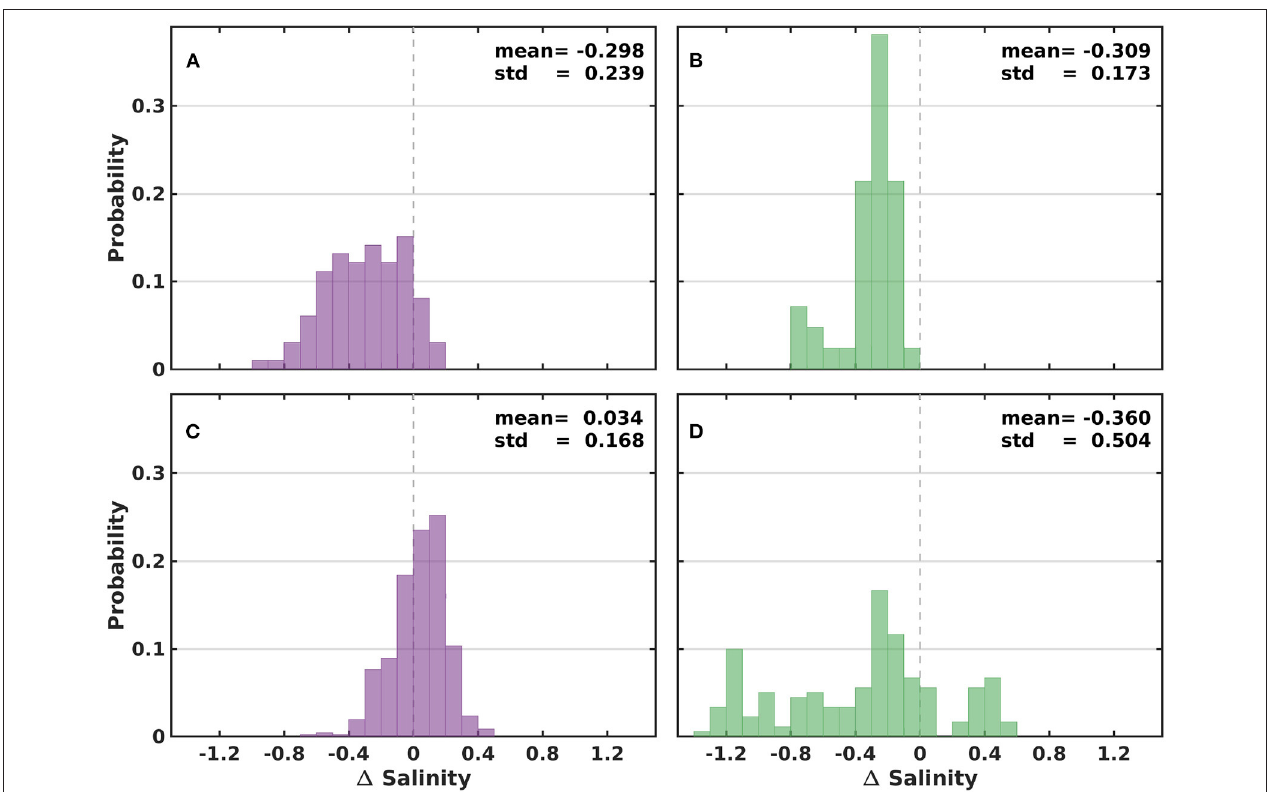
FIGURE 8 | Probability distributions of salinities observed by the FerryBox system minus those observed at Gabbard. (A,B) refer to FerryBox measurements taken when the ferry was closest to Gabbard (derived from the time series shown in Figure 6 ), while (C,D) refer to FerryBox observations at locations and times that were identified by simulated drift trajectories (see Figure 7 ). The two purple histograms comprise all those cases when simulated trajectories move from Gabbard to the ferry transect (same color code as in Figures 1 and 7 ), while the two green histograms combine all cases in which simulated trajectories move from the ferry toward